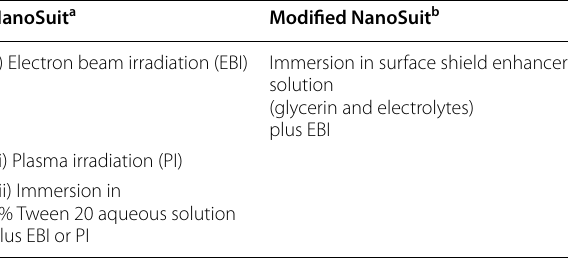
Table 1 Comparison of NanoSuit versions for live imaging and elemental